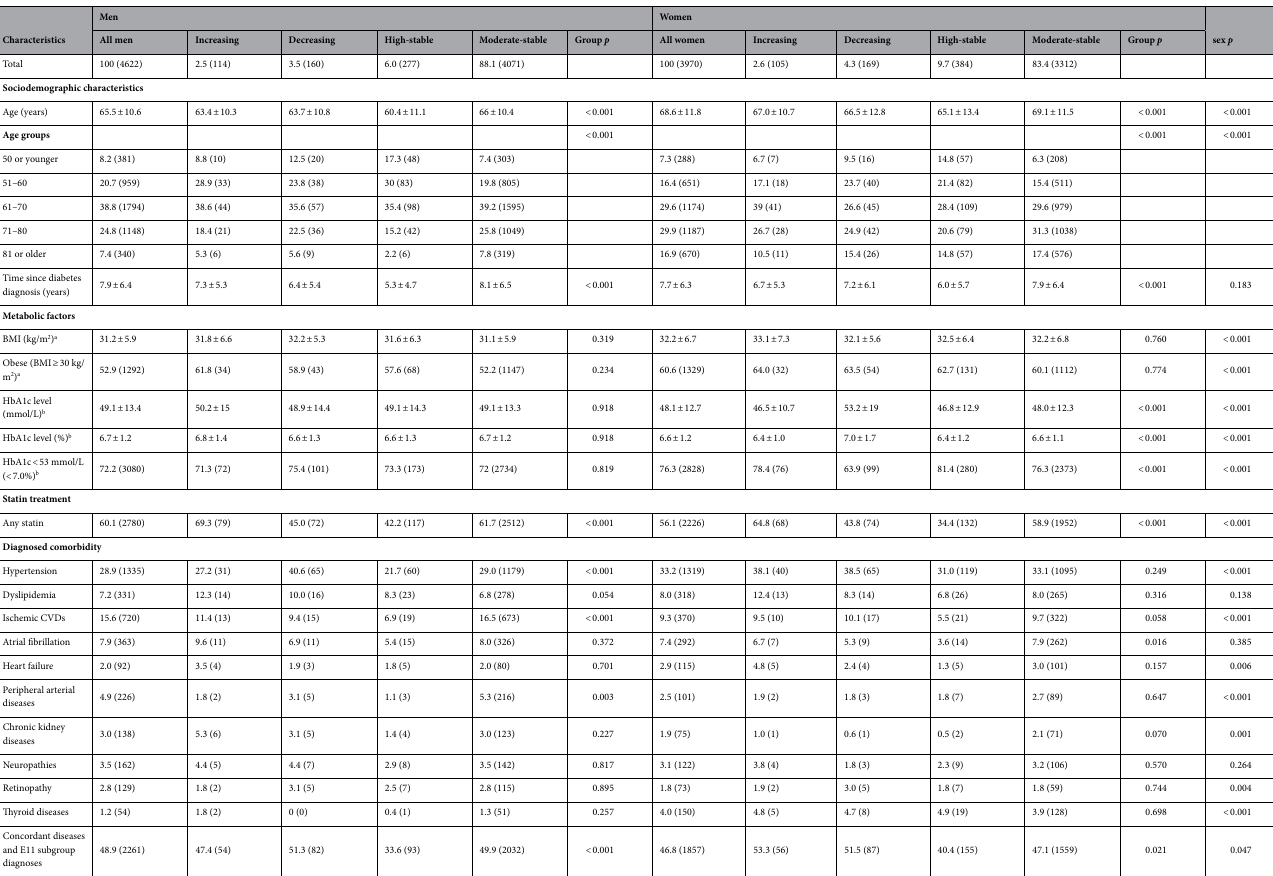
Table 1. Baseline characteristics by trajectory group for men and women. Values are expressed as % (n) for categorical variables or mean ± SD for continuous variables. p value comparisons across trajectory groups and sex are based on χ 2 test for categorical variables and Kruskal–Wallis test for continuous variables. a Number of missing BMI values for men (total: 2180, increasing: 59, decreasing: 87, high-stable: 159, moderate- stable: 1875) and women (total: 1776, increasing: 55, decreasing: 84, high-stable: 175, moderate-stable: 1462). b Number of missing HbA1c values for men (total: 354, increasing: 13, decreasing: 26, high-stable: 41, moderate-stable: 274) and women (total: 262, increasing: 8, decreasing: 14, high-stable: 40, moderate-stable: 200).